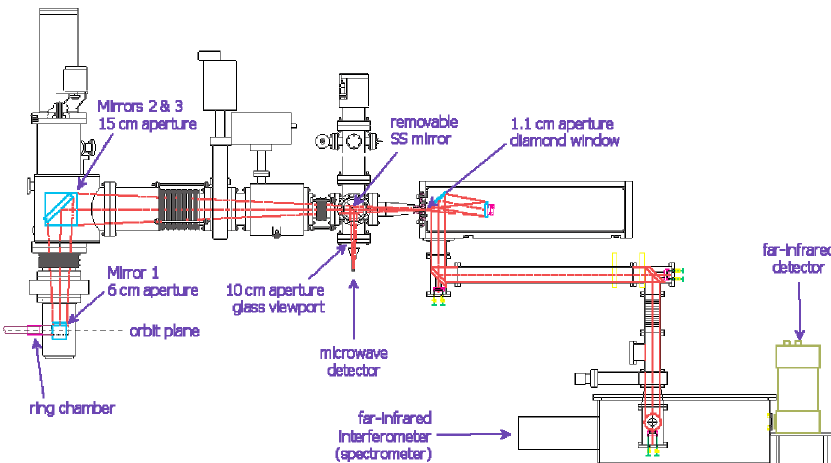
FIG. 1. (Color) Schematic layout of the U12IR beam line to the FIR spectrometer. The 1.1 cm diamond window and optical beam pipe are shown. Upstream of that window, a metal shutter (mirror) was inserted to deflect the microwaves through a viewport to a collector and